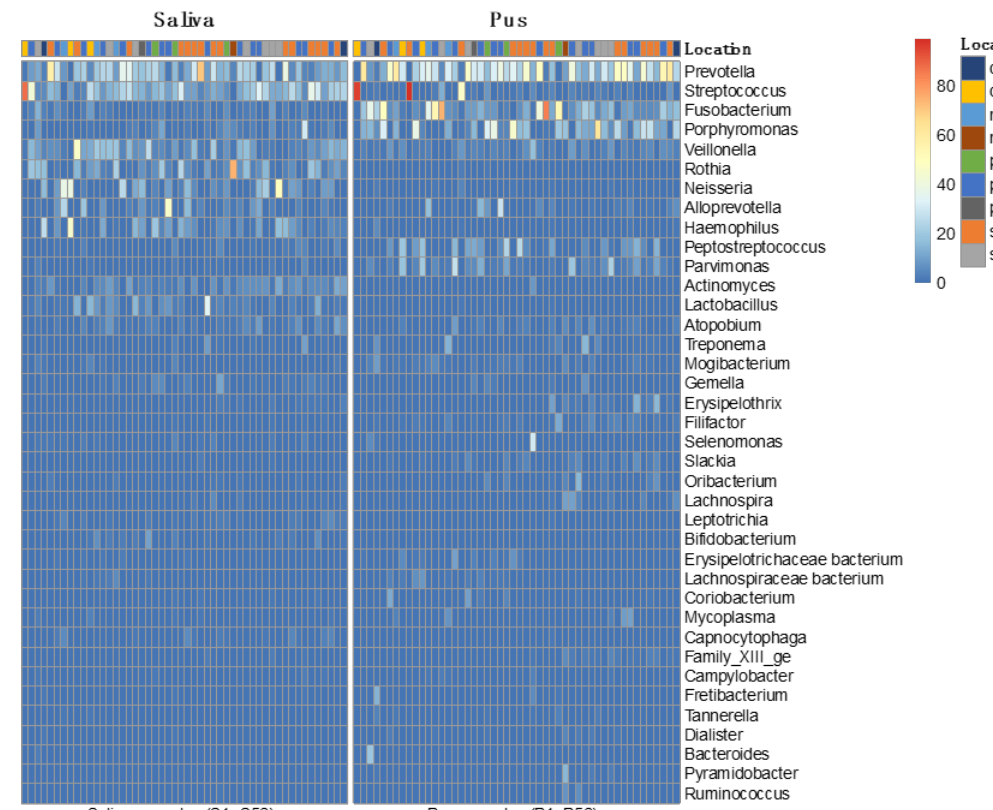
Figure 7. Heatmap of all saliva and pus samples ( n = 100). Colors show the relative frequencies (sum of rows > 20%). Saliva samples are shown on the left side and pus samples on the right side. It is obvious that the abundance of Porphyromonas and Fusobacterium is greater in pus while the abundance of Streptococcus is greater in saliva.